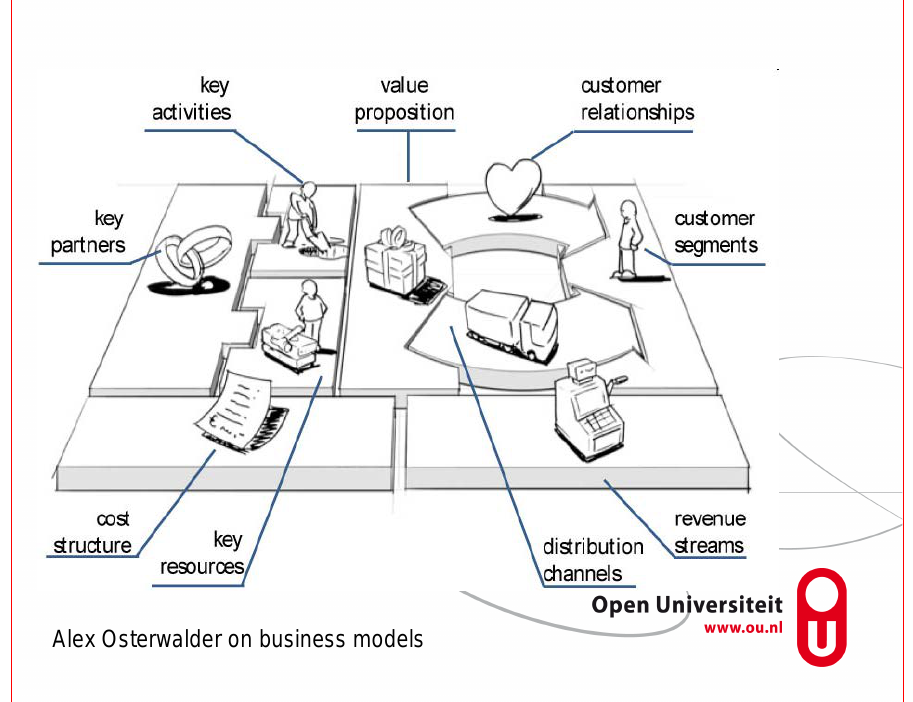
Figure 1 . Alex Osterwalder’s Business